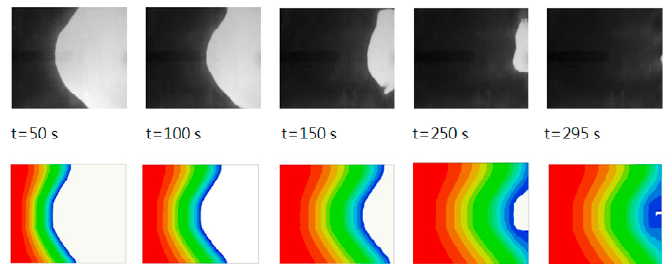
Figure 5. Comparison between the simulation results and the experimental data.